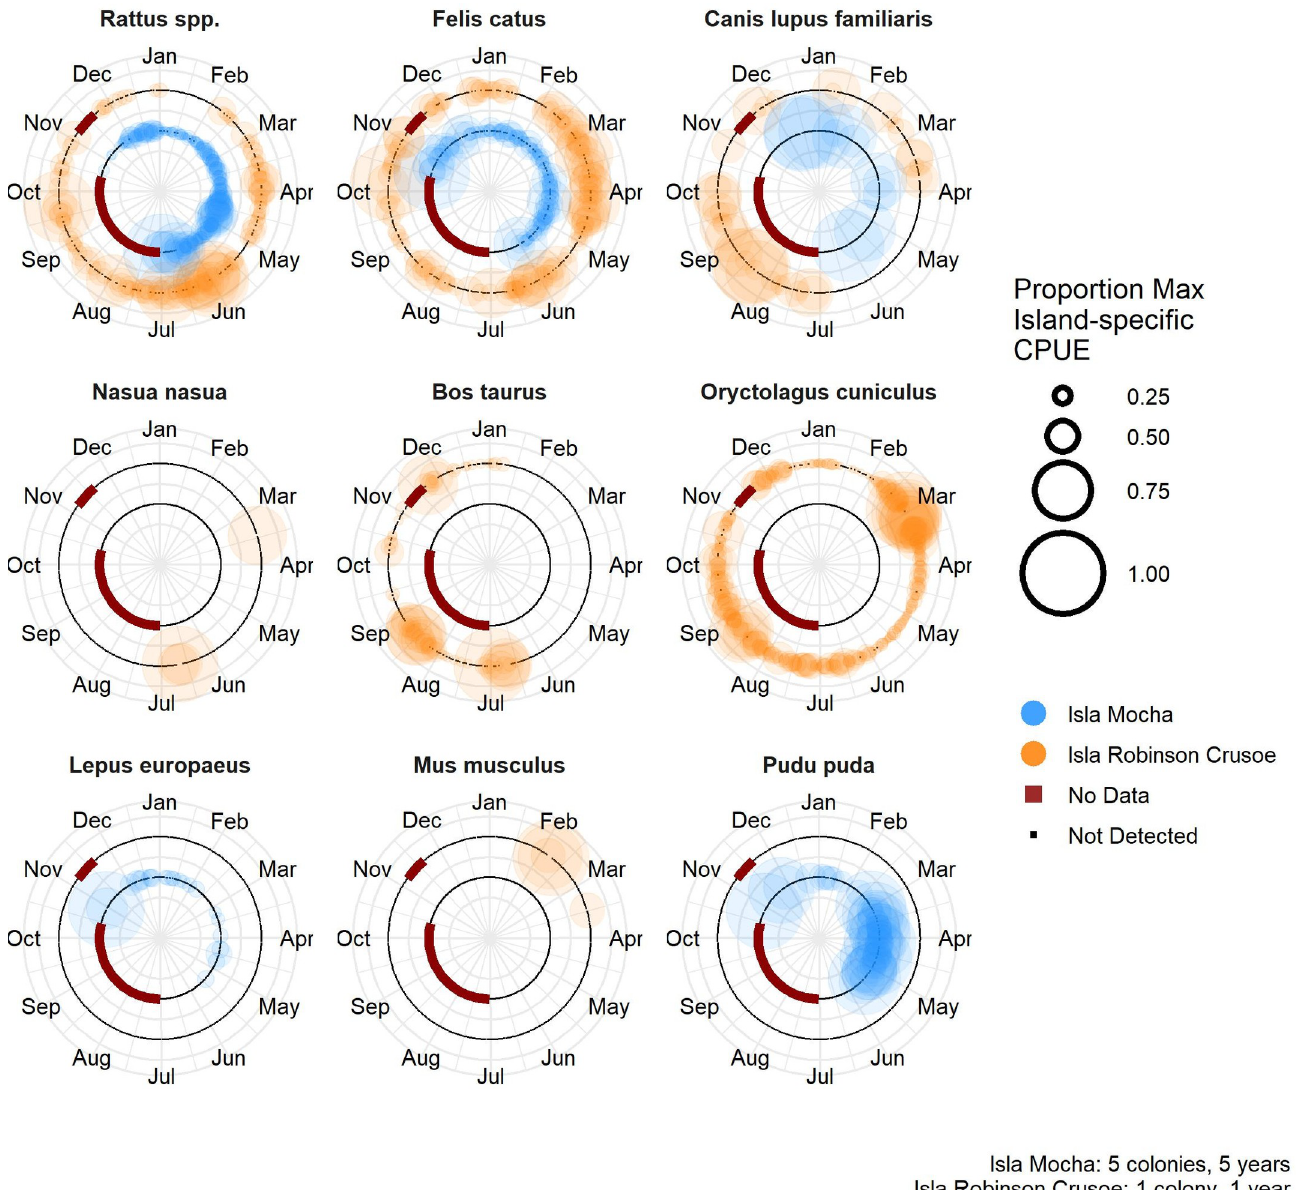
Fig 4. Seasonal island-specific attendance of mammals in pink-footed shearwaters colonies on Isla Mocha (inside circle, blue; five colonies, 2015–2020) and Isla Robinson Crusoe (outside circle, orange; one colony, 2019–2020), Chile. Proportion of island-specific maximum CPUE was calculated by dividing each species’ hourly CPUE by the maximum recorded hourly CPUE for that species on each island, and averaging the hourly results for each day. This unitless relative CPUE metric can be used to compare seasonal attendance across islands, but does not reflect actual magnitude or relative abundance of species because the maximum CPUEs were species- and island-specific. Circle size indicate s the proportion of the island-specific maximum CPUE for each day on each island. The largest point represent s the highest CPUE for that species on that island. Red line indicates no data. Black line indicates effort without detections on that date. Species with no colored data points were not observed on that island. All mammals shown were introduced with the exception of the pudu´ (Pudu pada), whose native status was uncertain. https://doi.org/10.1371/journal.pone.0254416.g004 population of pink-footed shearwaters [9]. The other approximately 10% nests on Isla Santa Clara, a smaller island adjacent to IRC in the Juan Ferna´ndez Archipelago [9], which is the only pink-footed shearwater breeding colony free of introduced vertebrates. Thus, our results